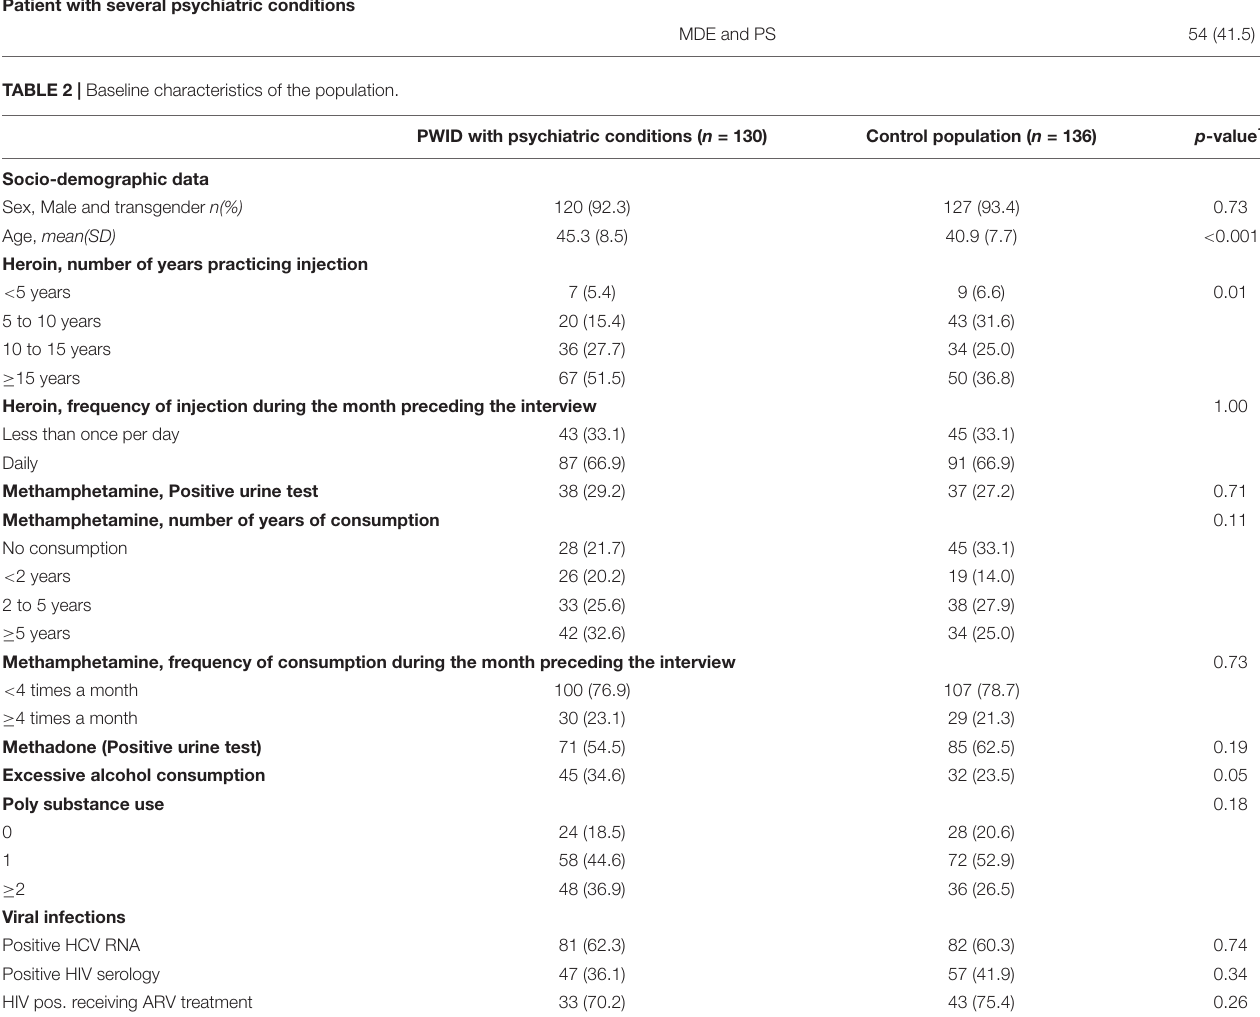
TABLE 2 | Baseline characteristics of the population.